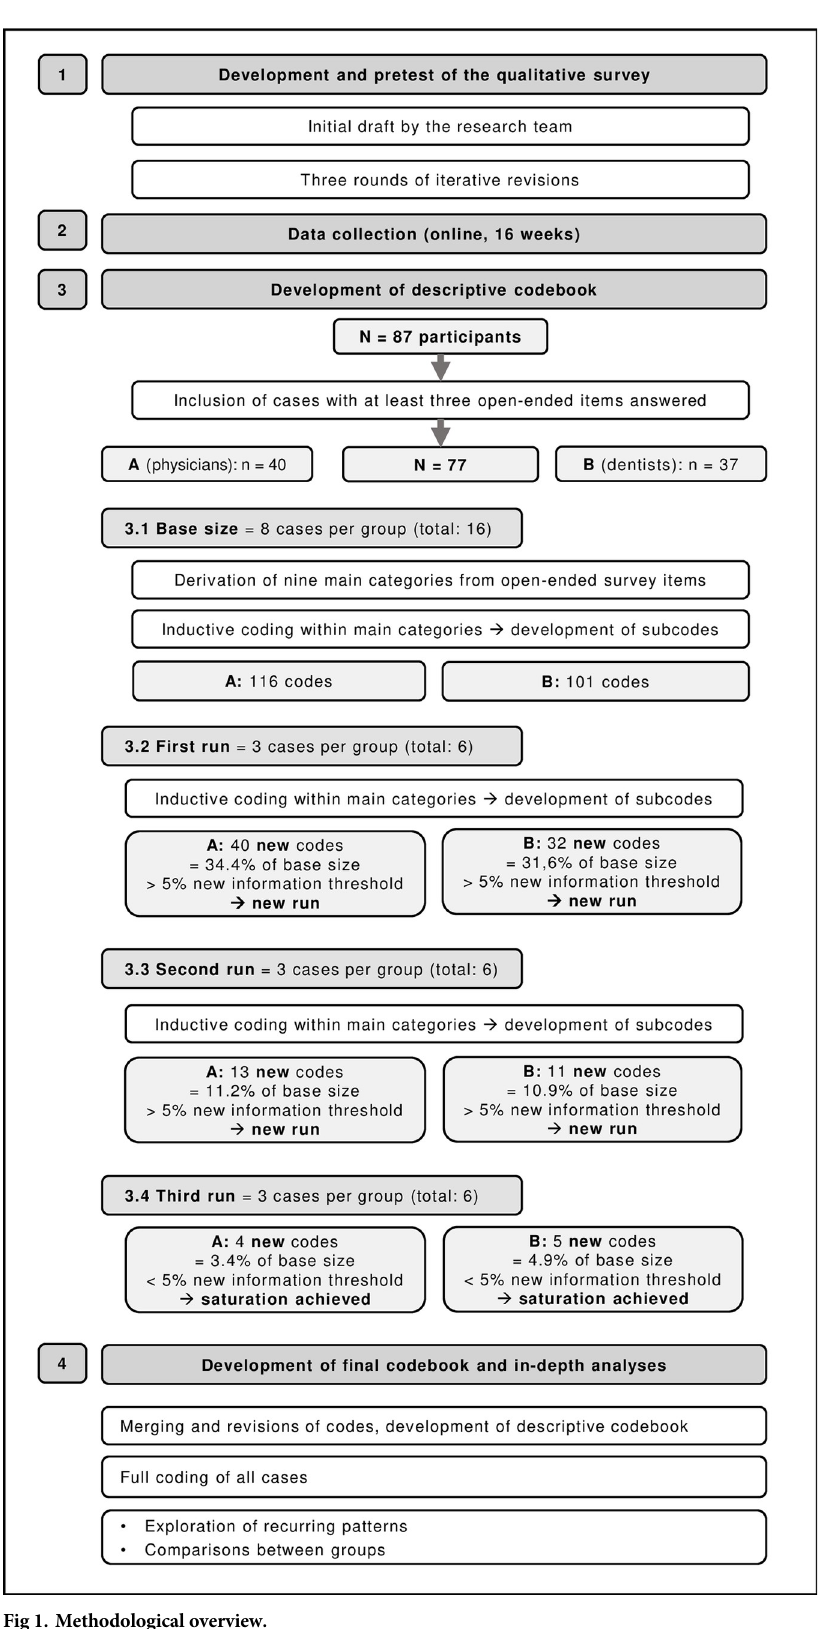
Fig 1. Methodological